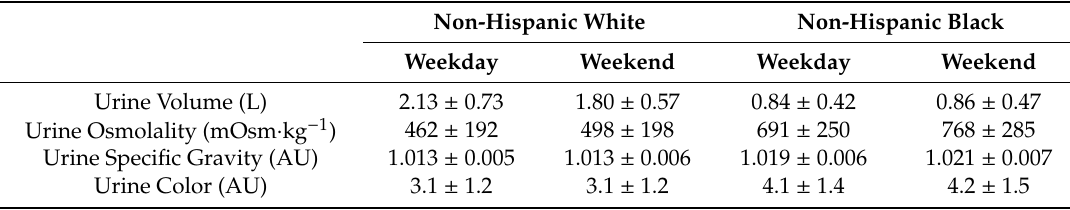
Table 2. Weekday and weekend day 24 h urinary hydration measures.